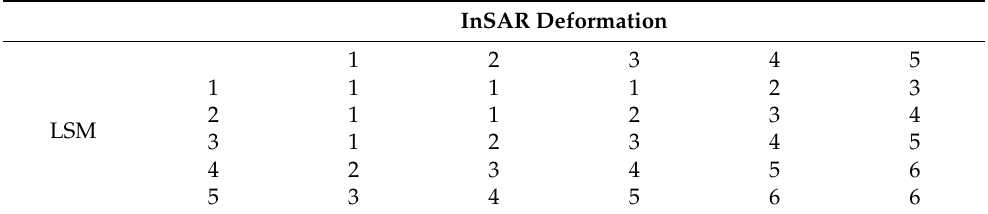
Table 4. The correction matrix of dynamic landslide susceptibility maps. LSM degree is 1 = low; 2 = low-medium; 3 = medium; 4 = medium-high and 5 = high.